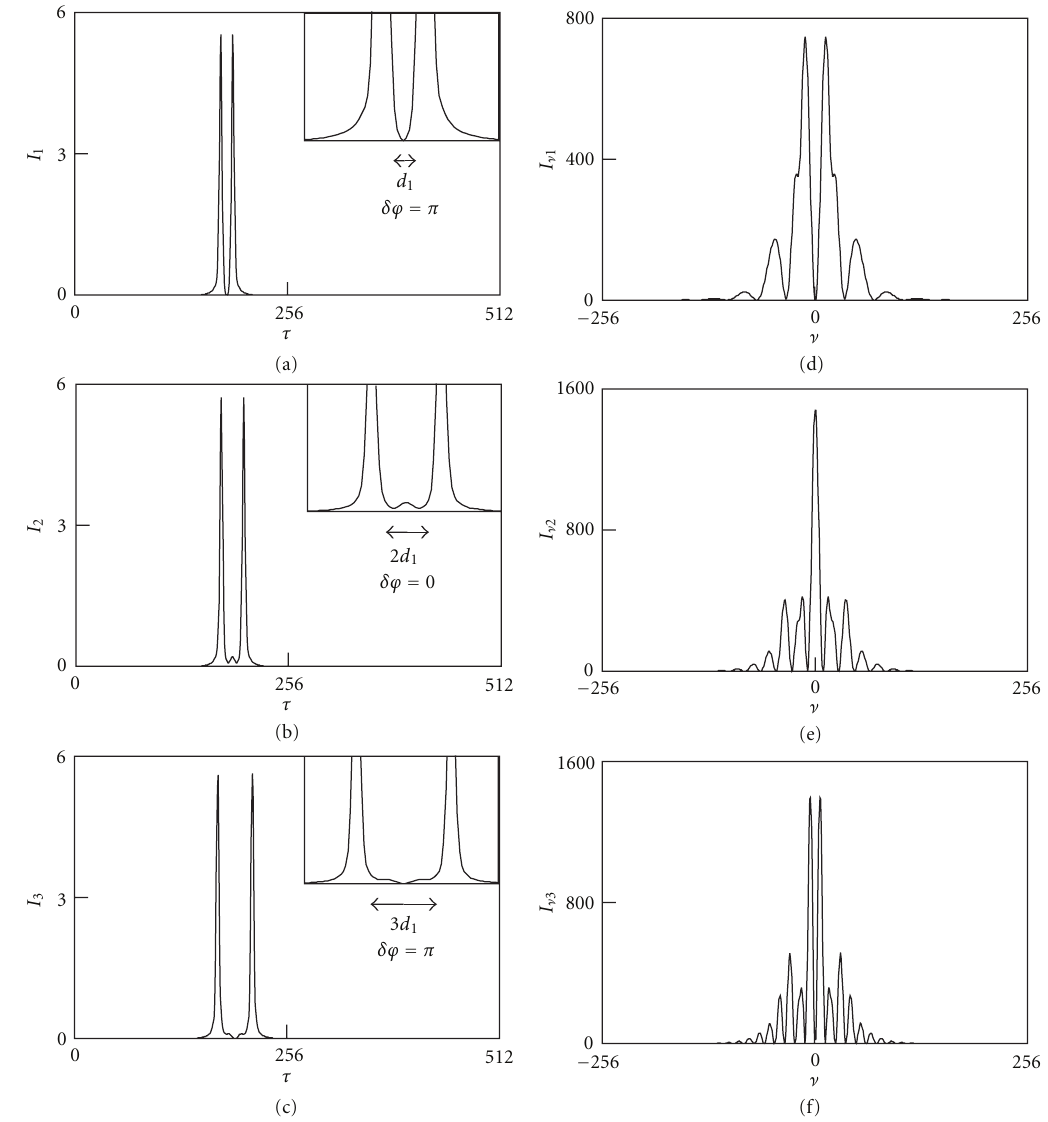
Figure 12: Temporal and spectral distributions of intensity of the two-soliton molecule (a), (d) for the ground steady state (minimal distance d 1 between solitons), (b), (e) for the first excited steady state, and (c), (f) for the second excited steady state. All steady states are stable. The laser parameters are the same as in the case of Figure